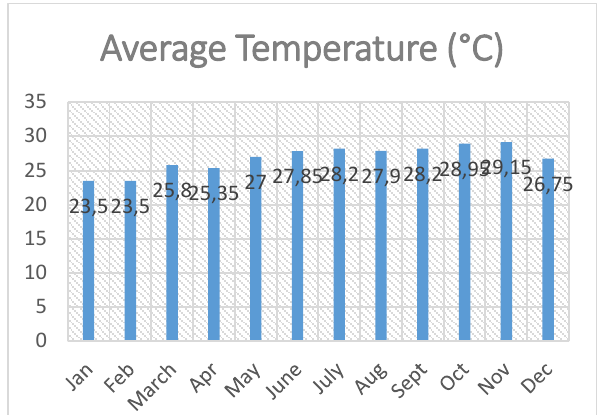
Figure 3. Annual variation of monthly average